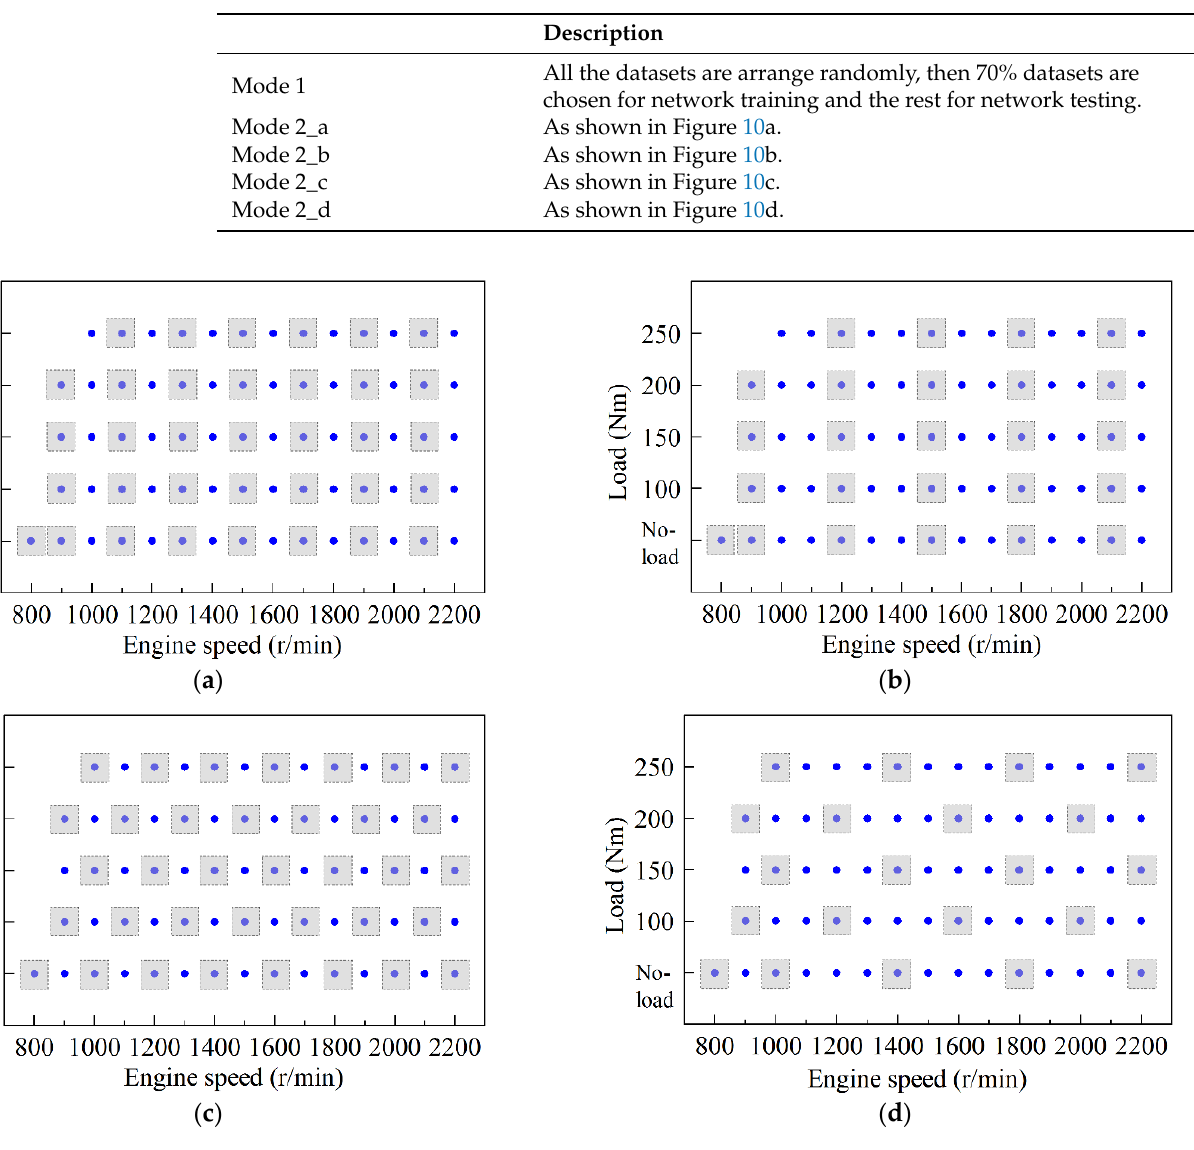
Figure 10. Different arrangements of training and testing datasets. ( a ) Arranging training data in 100 r/min interval. ( b ) Arranging training data in 200 r/min interval. ( c ) Arranging training data in dense speed and load interval. ( d ) Arranging training data in sparse speed and load interval. The engine running conditions in grey shadows are used for network training, the rest for network testing.